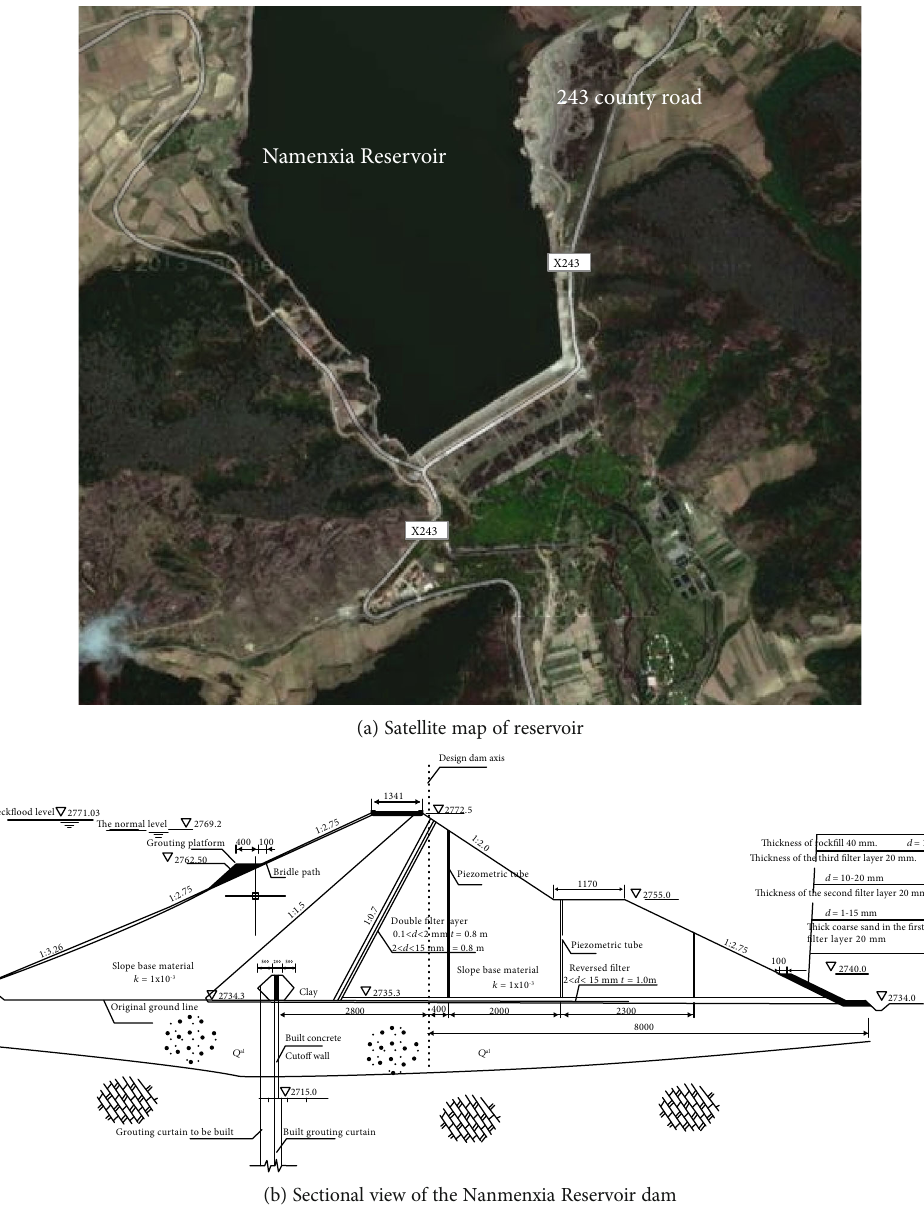
Figure 14: Satellite map of reservoir (a) and sectional view of the Nanmenxia Reservoir dam